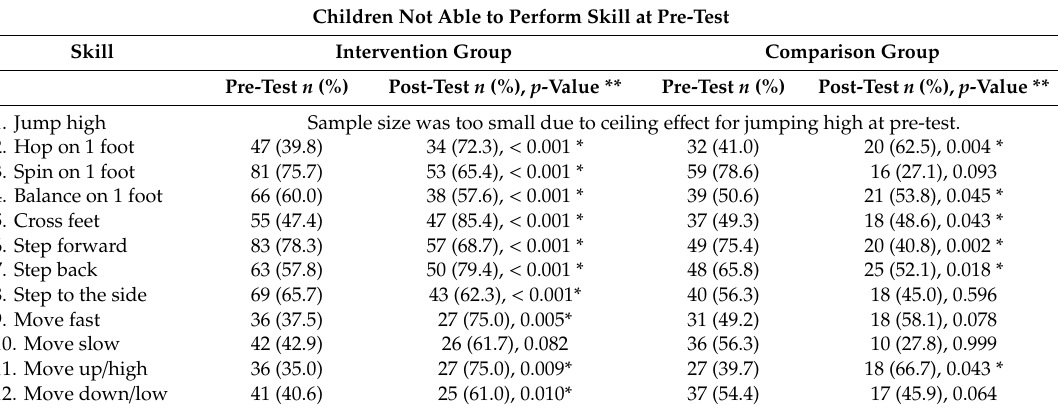
Table 2. 12-Skills, COMPARISON Study, All 4 Kids ©